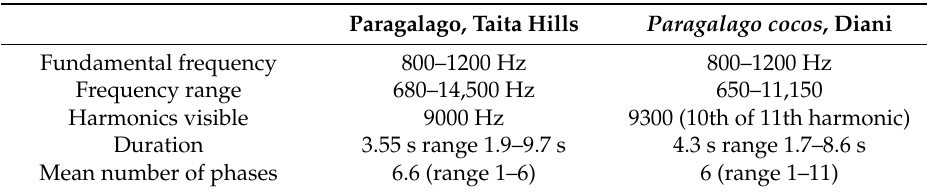
Table 6. Comparison of incremental calls recorded from the Taita Hills in this study and those of Paragalago cocos recorded from Diani, Kenya (Butynski et al.,